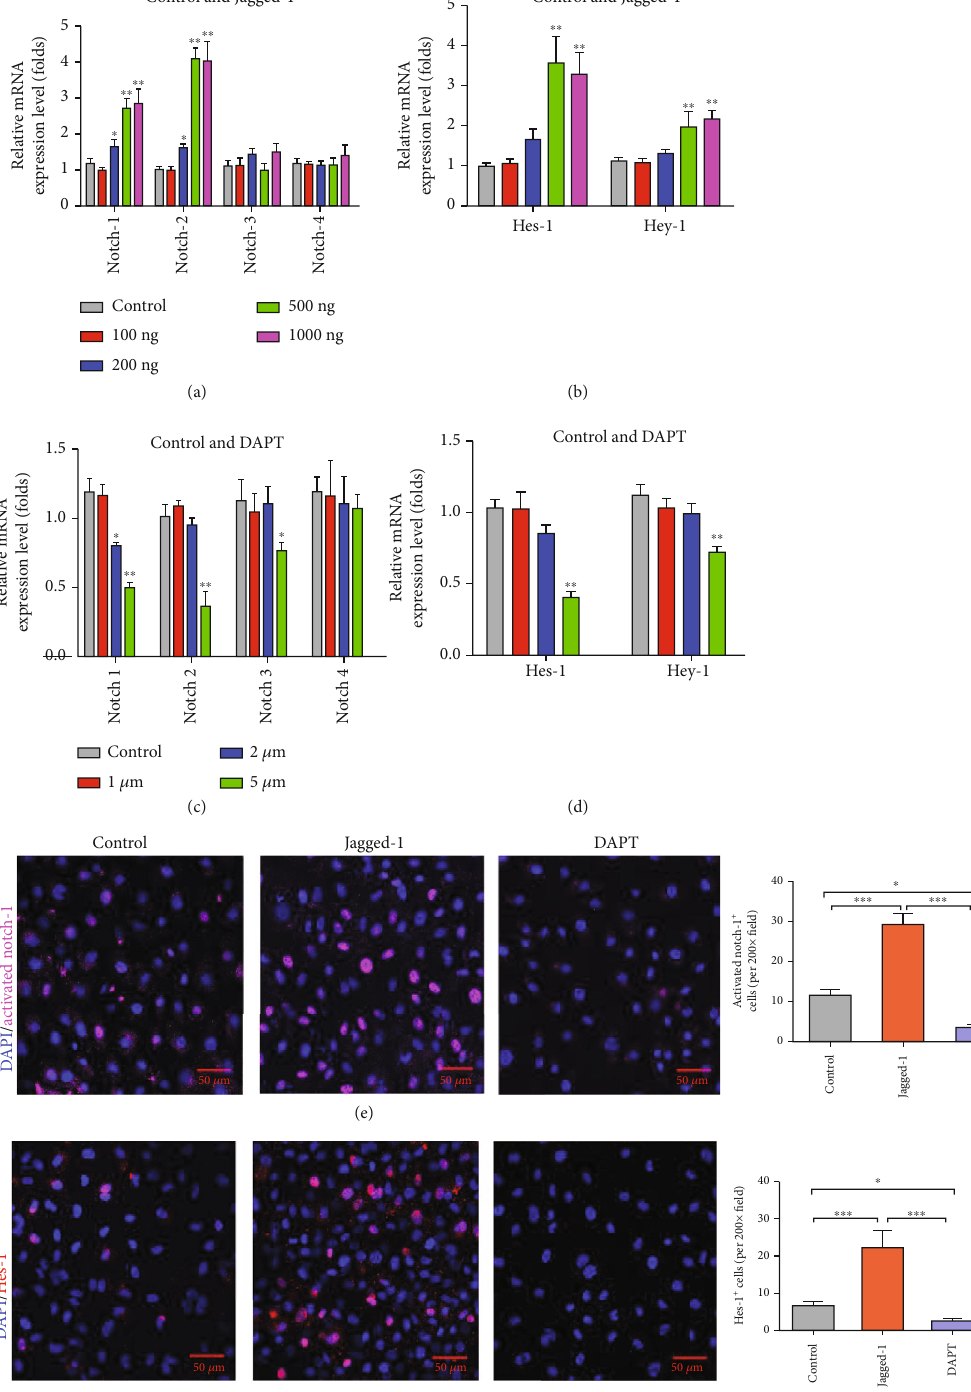
Figure 3: Notch signaling and its target genes in EPCs were regulated by the treatment of jagged-1 and DAPT for 2 days. (a, b) The mRNA expression of Notch signaling and its target genes were signi fi cantly upregulated with the treatment of jagged-1 for 2 days compared with the control. (c, d) The mRNA expression of Notch signaling and its target genes were signi fi cantly downregulated with the treatment of DAPT for 2 days compared to the control. The p values were calculated by t -test. ∗ p < 0 : 05 , ∗∗ p < 0 : 01 , and ∗∗∗ p < 0 : 001 for pairwise comparison. (e) Immuno fl uorescence staining showed that activated Notch-1 was signi fi cantly upregulated with jagged-1 treatment while decreased with DAPT treatment. (f) Immuno fl uorescence staining showed that Hes-1 was signi fi cantly upregulated with jagged-1 treatment while decreased with DAPT treatment. The p values were calculated by ANOVA. ∗ p < 0 : 05 , ∗∗ p < 0 : 01 , and ∗∗∗ p < 0 : 001 for pairwise comparison among the